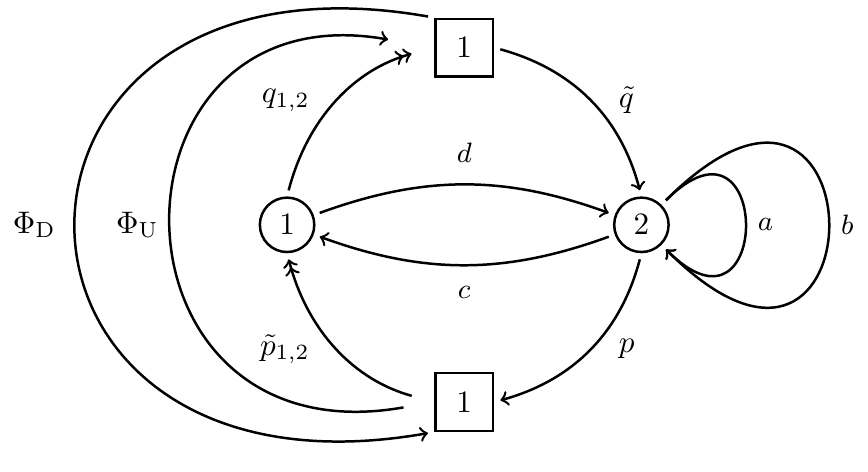
Figure 6 . Flavored version of Laufer’s n = 1